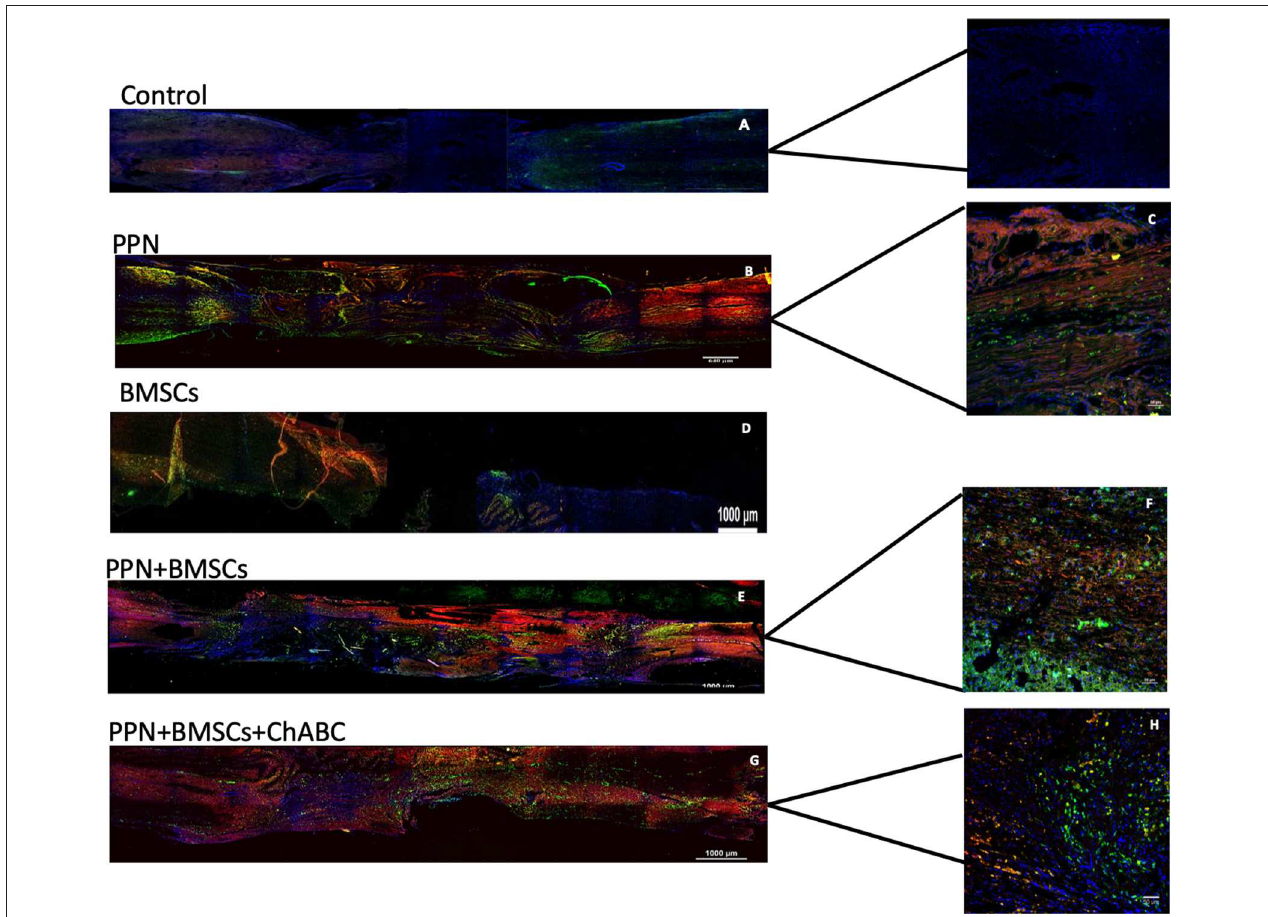
FIGURE 4 | Representative images of axonal regeneration. In (A,B,D,G) , descending fibers (red, mini-ruby dextran, tetramethylrhodamine) and ascending fibers (green, emerald fluoro dextran fluorescein) are shown in the rostral zone (left), epicenter (central zone), and caudal zone (right) of the spinal cord. In (C,F,H) positive fibers from each tracer are observed in the transplant zone (central zone). Nuclei dyed in blue with Hoechst. Scale for A,B,D,F = 1,000 µ m and for C,E,G = 50 µ